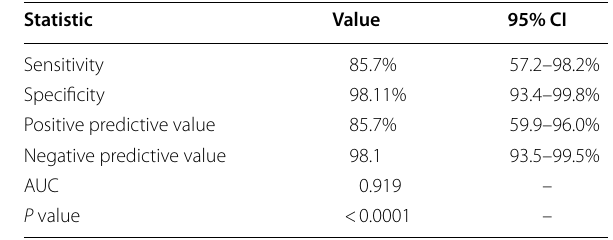
Table 3 Performance of MDCT chest in the detection of breast multifocality and multicentricity